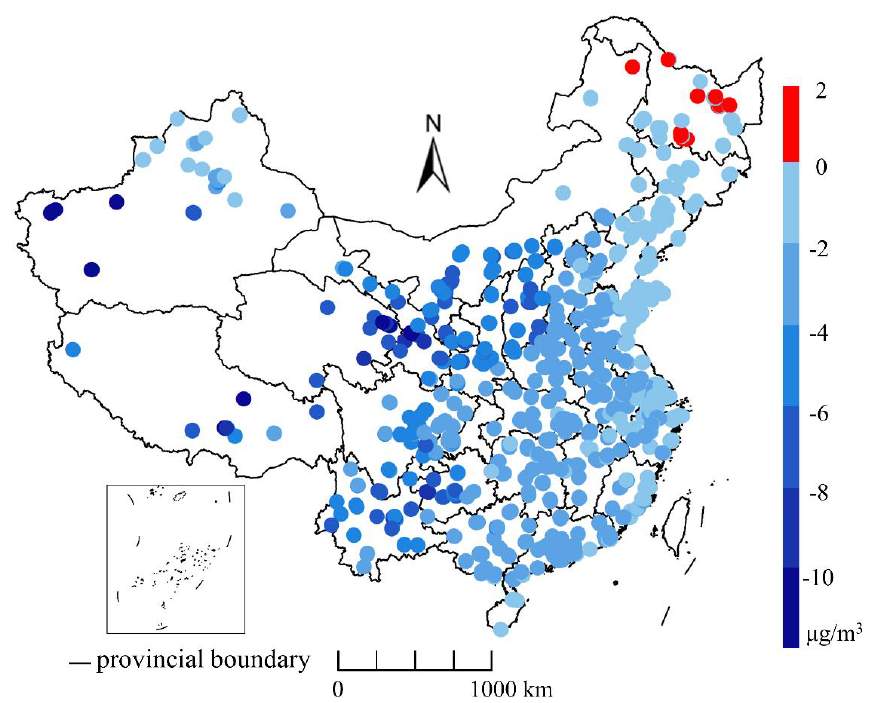
Figure 1. Reported shifts of annual average concentrations of PM 2.5 due to the amended monitoring protocol at Mainland China’s national air quality monitoring stations (September 2017–August 2018). Annual PM 2.5 averages decreased at 99% of air quality monitoring stations.